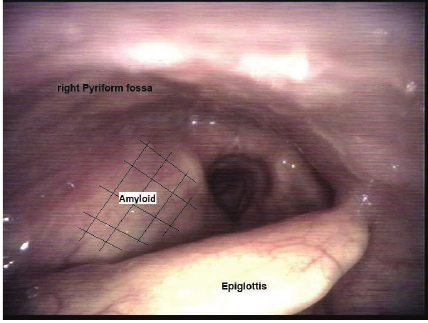
Figure 1: Supraglottic amyloid. Figure 2: Amyloid tumour of the larynx. X 40—connective tissue partly covered by squamous mucosa. Within the connective tissue is eosinophilic material which stains positively with Congo red. This Congo red stained material shows apple green birefringence under polarised light. The appearances are consistent with